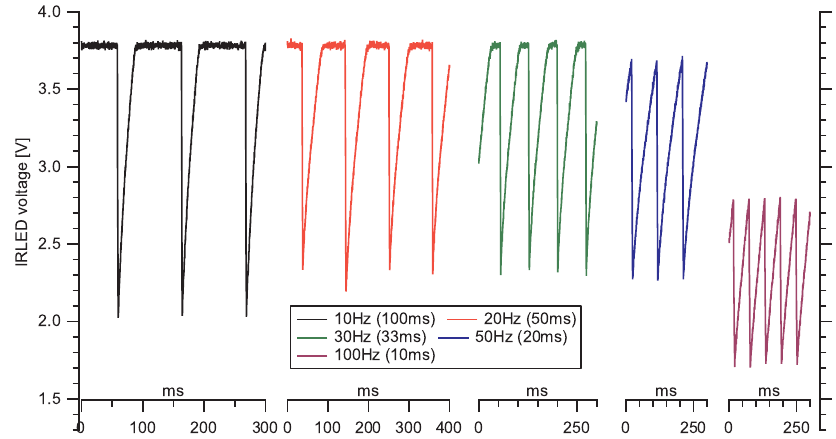
Figure 2. Observed V-LED driving voltage at different driving frequencies: (from left to right) 10, 20, 30, 50 and 100 Hz. Rightmost (100 Hz) is the manufacturer’s recommended driving frequency.